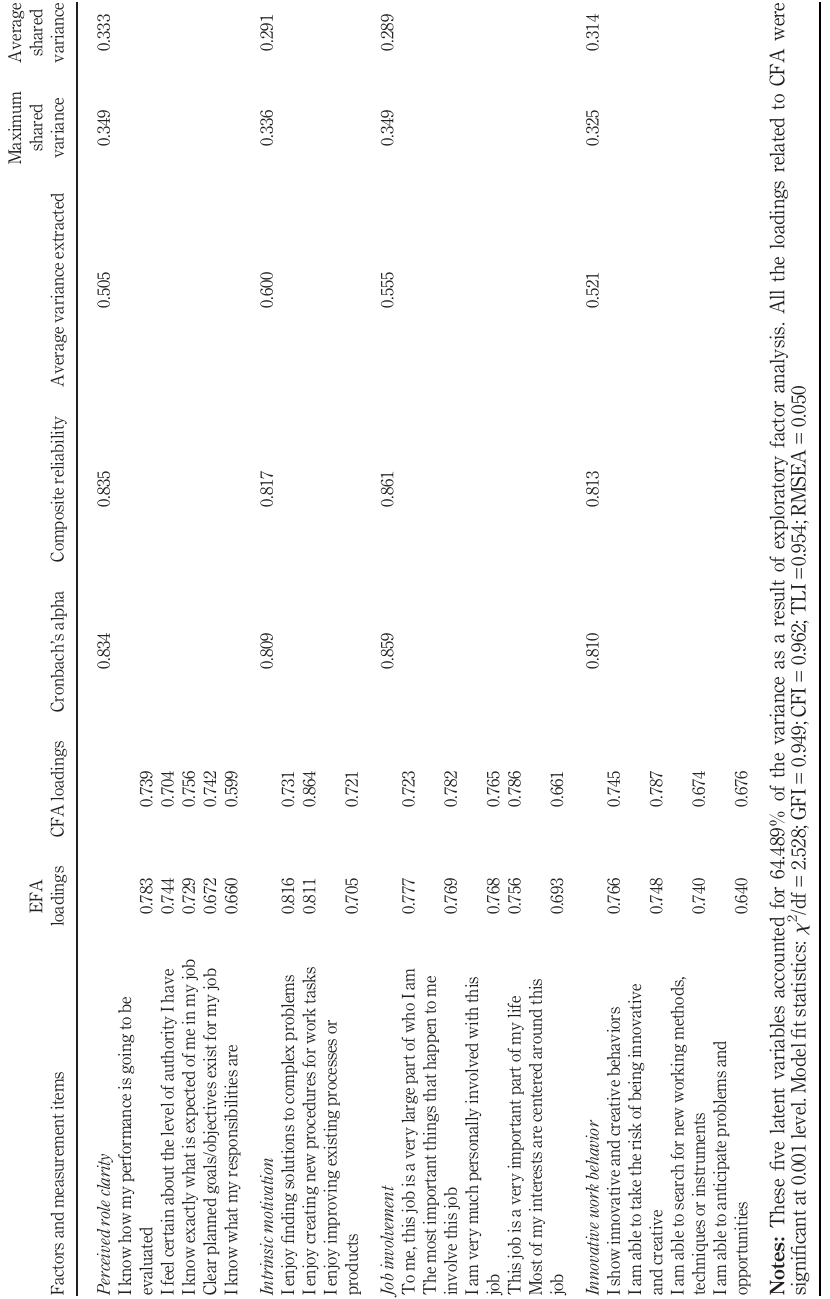
variables with EFA and CFA loadings, validity and reliability